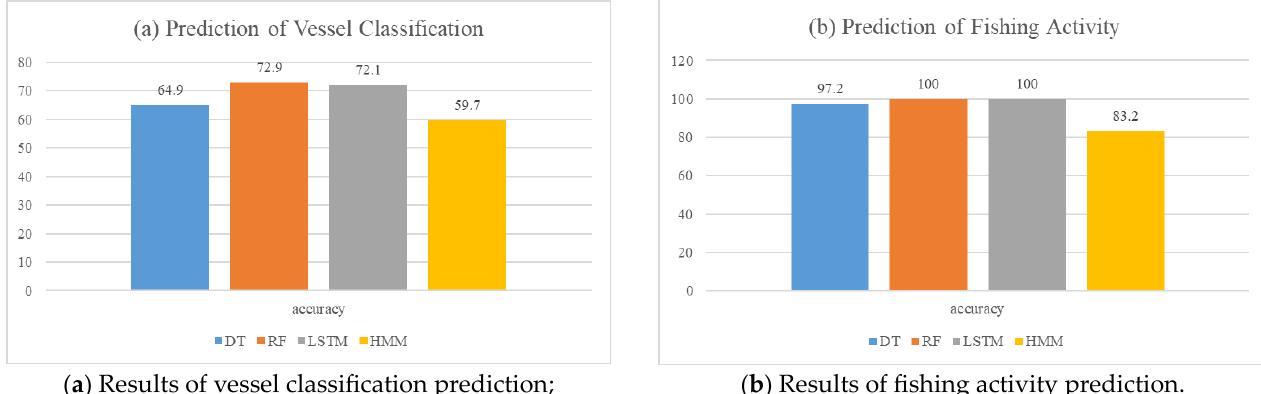
Figure 16. Comparison of Accuracy in Prediction Fishing Activities and Vessel Types.